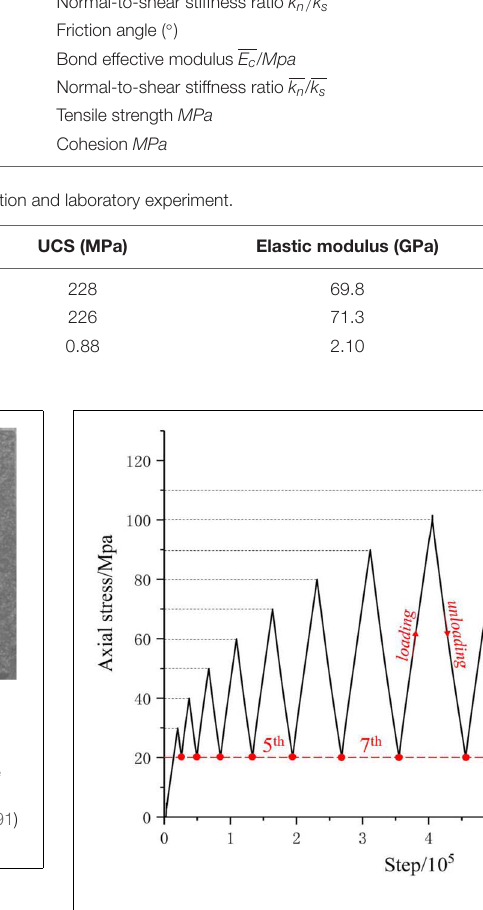
FIGURE 4 | Stress path: triaxial cyclic loading and unloading under increased upper limit